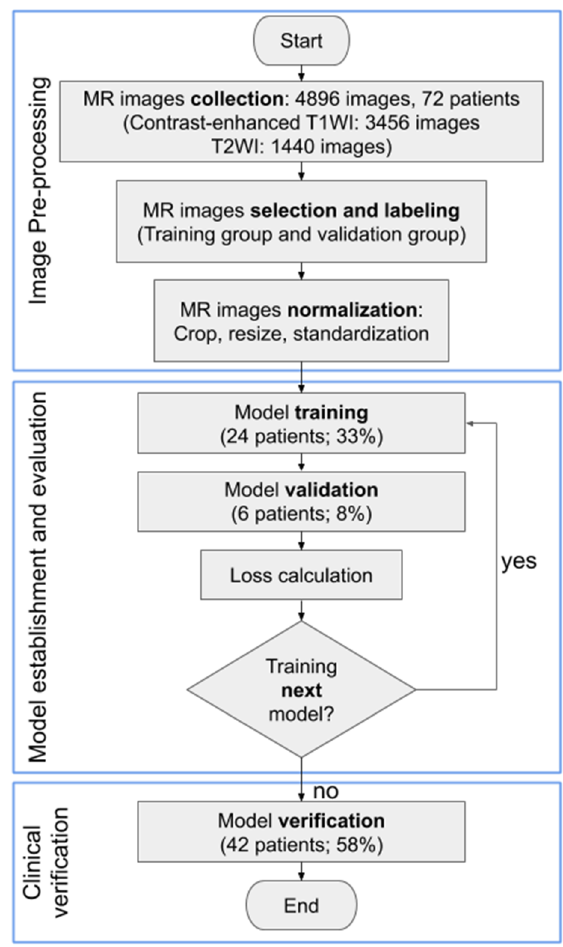
Figure 1. Workflow diagram demonstrating the process and preparation of the MR image dataset and training convolutional neural network models. The consecutive steps of MR image analysis include image upload, convolutional neural network model selection, and diagnosis output.